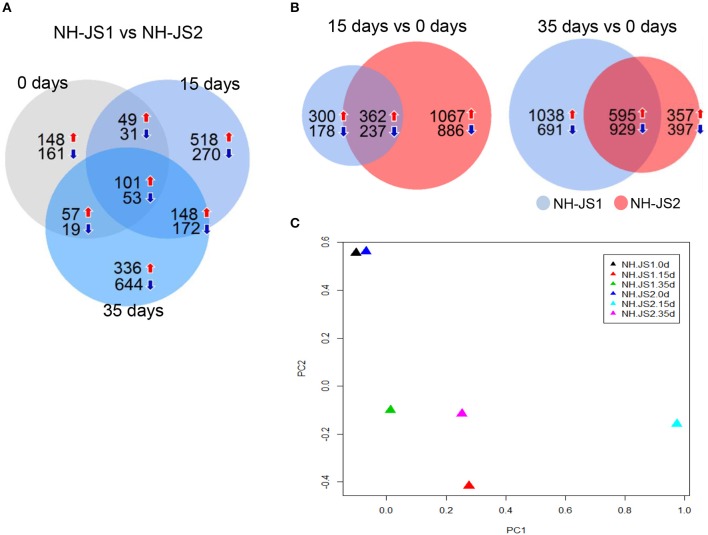
Comparison of genes differentially expressed between two inbred lines under vernalization conditions. (A) Differentially expressed genes (DEGs) between the two inbred lines at each vernalization time (0, 15, and 35 days). (B) Comparisons of DEGs between 15 and 0 days, and between 35 and 0 days between two inbred lines. Red and blue arrows indicate up-regulation and down-regulation, respectively. Numbers indicate genes differentially expressed in NH-JS1 relative to NH-JS2. (C) Principal component analysis of DEGs between two inbred lines under normal and vernalization conditions. Triangles of each color correspond to a different time point. The largest variation between NH-JS1 and NH-JS2 was observed at 15 days of vernalization.